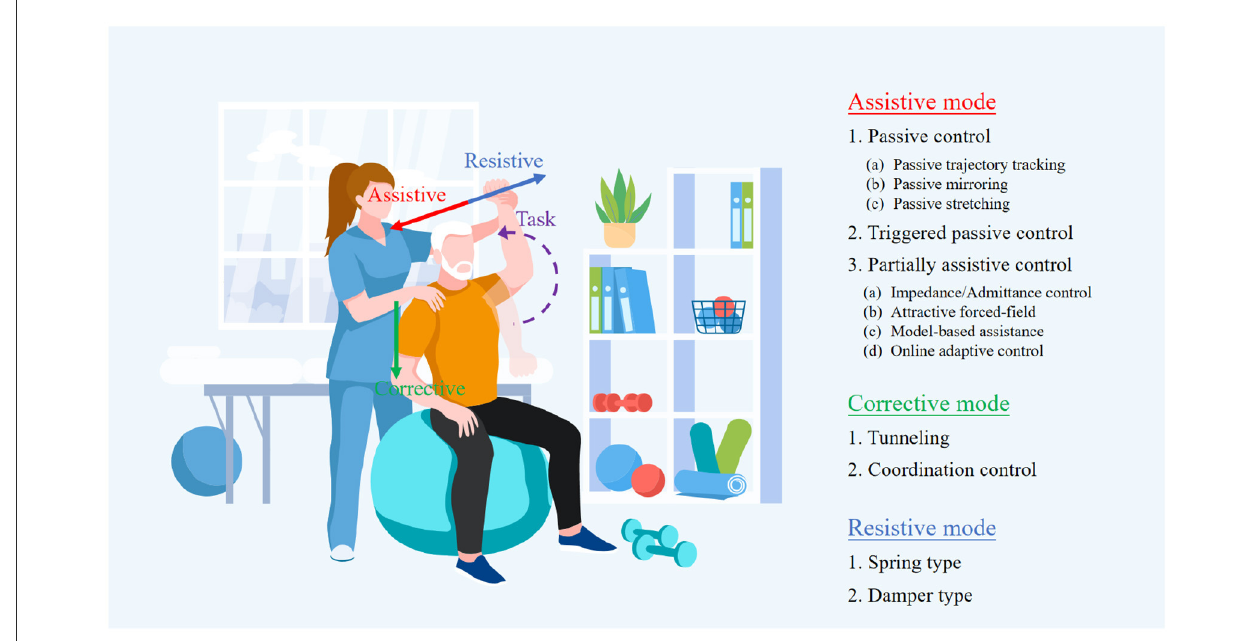
FIGURE6 Operation modes of exoskeleton for people with different levels of